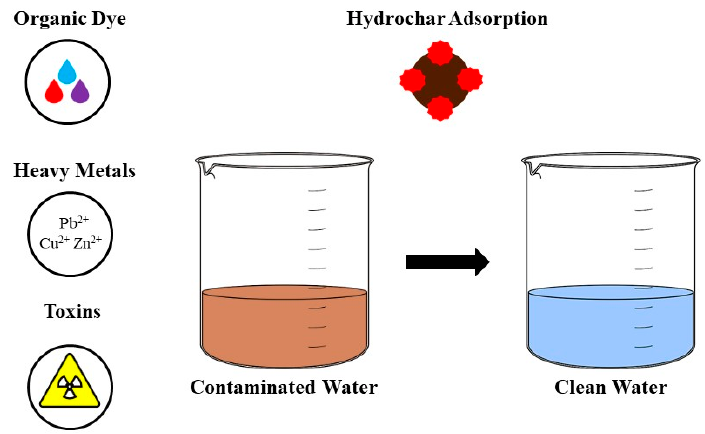
Figure 2. Contaminant removal from water by hydrochar.